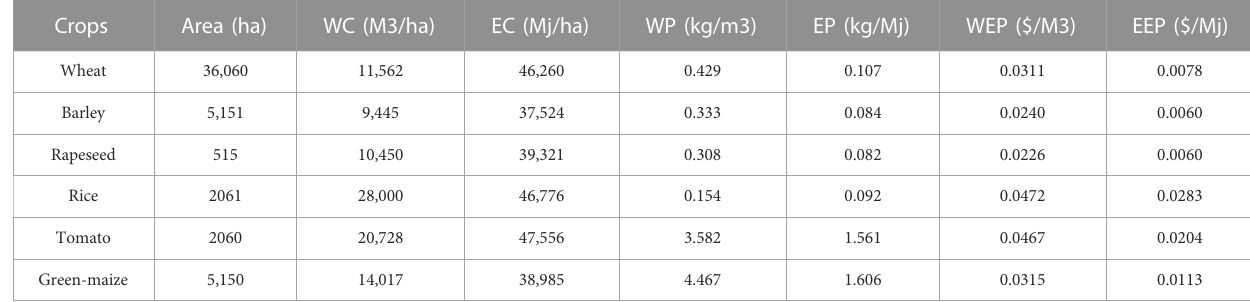
TABLE 2 The current cultivation area and calculated criteria of WEFN. Crops